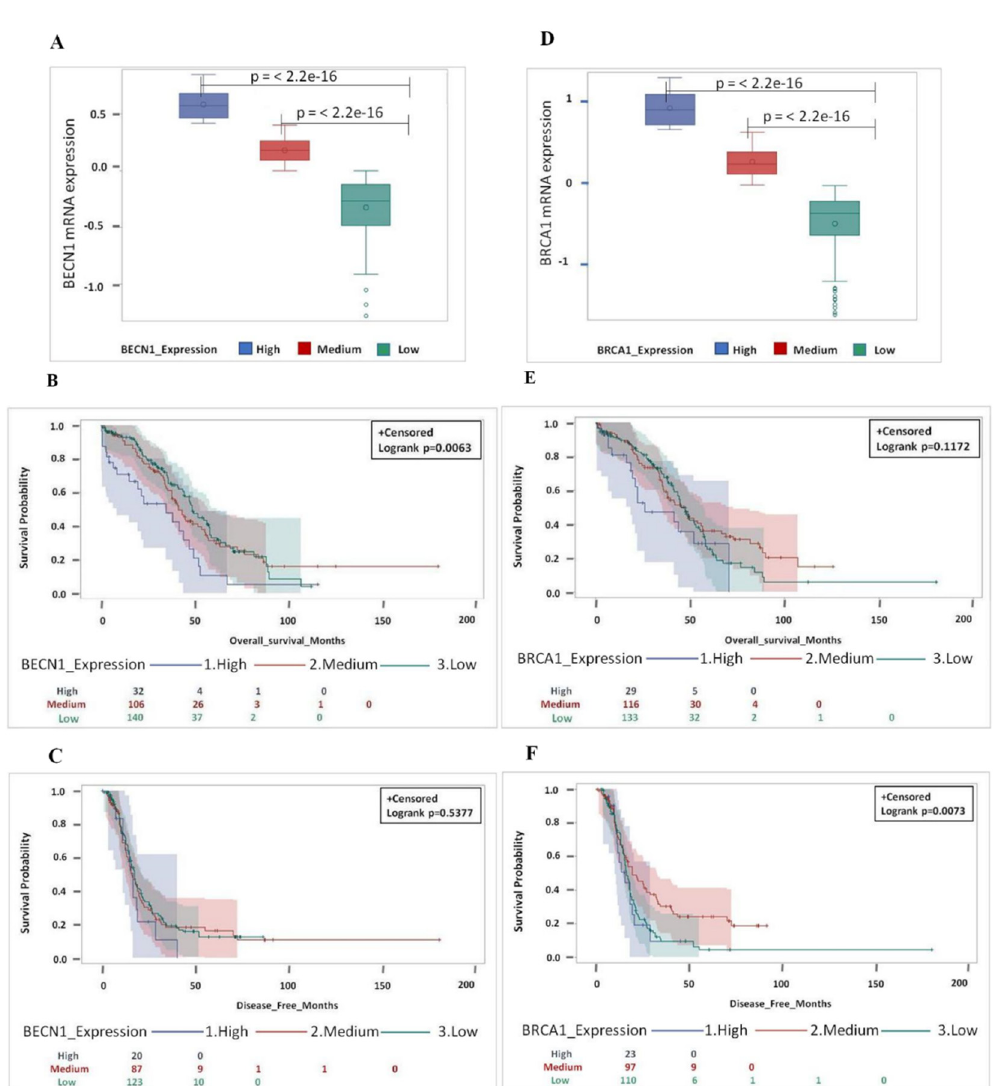
Figure 6. Low expression of both BECN1 and BRCA1 independently gives better and longer overall survival as well as disease-free survival in TP53 -mutated patients. ( A ) Box-plot showing the distribution of BECN1 expression based on expression levels (high, medium and low). ( B ) Overall and ( C ) disease-free survival for HGSOC patients based on BECN1 expression levels (high, medium and low). ( D ) Box-plot showing the distribution of BRCA1 expression based on expression levels (high, medium and low). ( E ) Overall and ( F ) disease-free survival analysis for HGSOC patients based on BRCA1 expression levels (high, medium and low). (Note that for BECN1 OS data were not available for 1 patient (medium group 1 pt: 106 pt’s; medium group total n = 107 pt’s) while for BECN1 —DFS data were missing for 49 patients (high group 12 pt’s: 20 pt’s + medium group 20 pt’s: 87 pt’s + low group 17 pt’s: 123 pt’s; total n = 279 pt’s), respectively. For BRCA1 - OS data were not available for 1 patient (low group 1 pt: 133 pt’s; low group total n = 134 pt’s) while for BRCA1 -DFS data were missing for 49 patients (high group 6 pt’s: 23 pt’s + medium group 19 pt’s: 97 pt’s + low group 24 pt’s: 110 pt’s; total n = 279 pt’s),